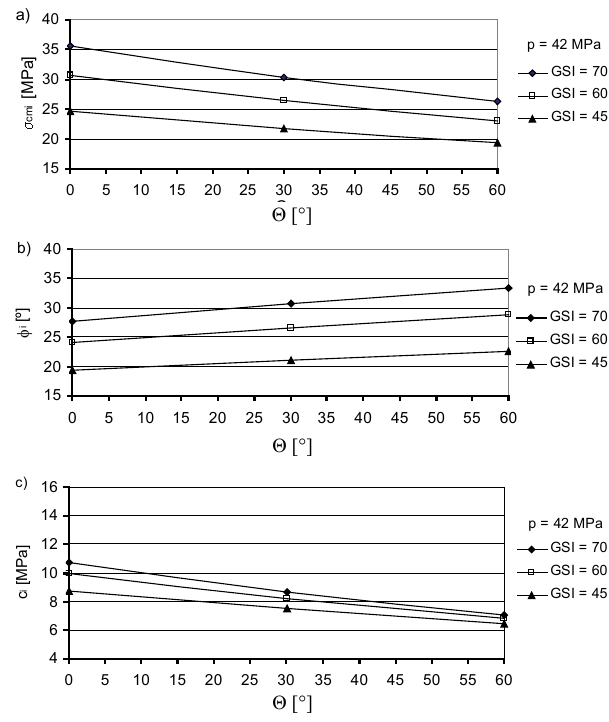
Fig. 5. Influence of the Lode angle Θ in deviatoric plane on a global compressive strength σ cmi (a), the angle of internal friction ϕ i (b) and cohesion c i (c) of the rock